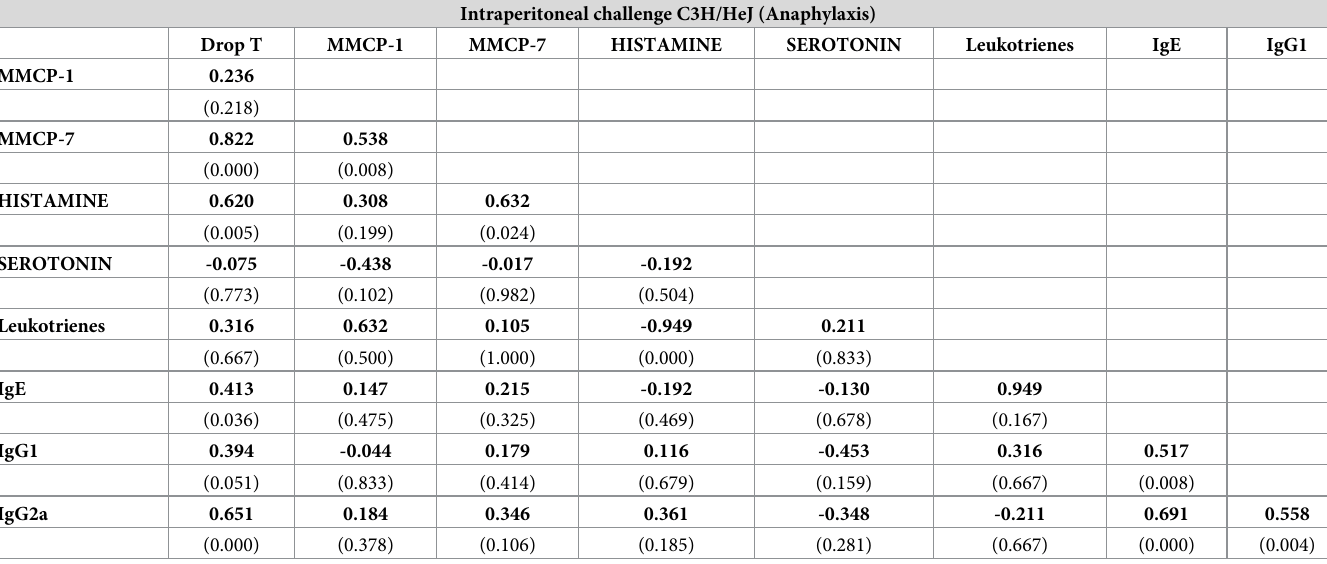
Table 4. Correlation between mast cell mediators measured in serum and anaphylaxis symptoms in C3H/HeJ mice after intraperitoneal challenge.